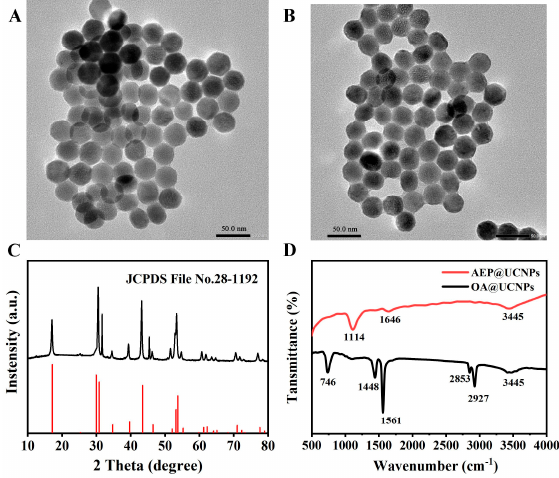
Figure 1. The TEM image of OA@UCNPs ( A ) and AEP@UCNPs ( B ); ( C ) XRD of AEP@UCNPs; ( D ) FTIR spectra of OA@UCNPs and AEP@UCNPs. Additionally, the fl uorescence spectra of the UCNPs before and after AEP modi fi ca- tion were analyzed, as shown in Figure S1. These results con fi rmed that AEP modi fi cation had no signi fi cant e ff ect on the fl uorescence properties of the UCNPs.